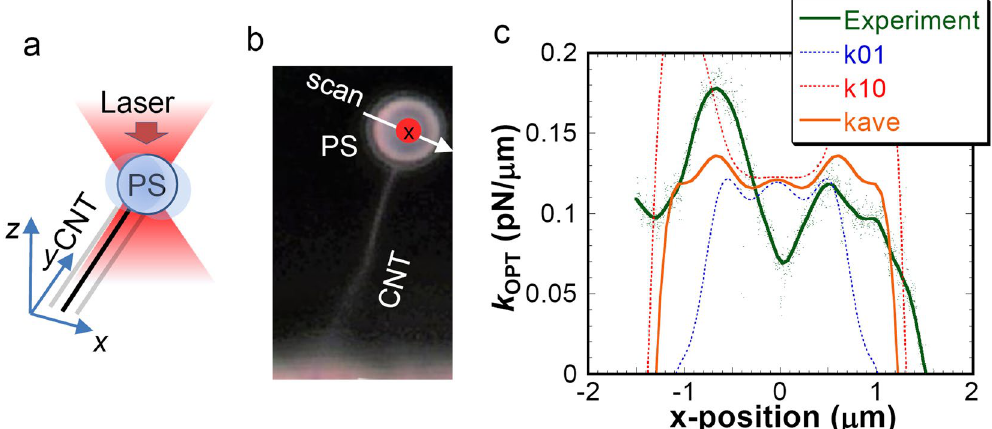
Figure 4. Spatial profile of k OPT in the x - y plane. ( a ) Schematic illustration of the measurement. The spatial profile of the k OPT was measured by changing the relative position of the focal position to the PS sphere. ( b ) Scanning direction of the focal point on the PS sphere for spatial profile of k OPT,x . The size of red solid circle represents the laser beam diameter. ( c ) x -position dependence of measured k OPT at the light intensity of 100 μ W. Theoretical curves are also